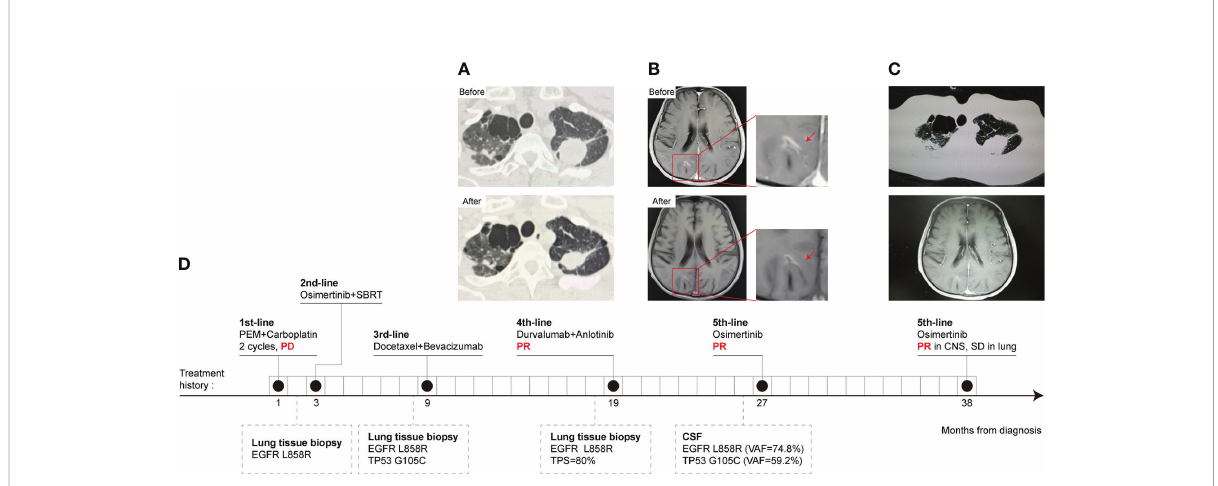
FIGURE 2 CT scans, treatment history, and gene mutation of Case 2 at different clinical time points as shown. (A) Chest CT scans. PR was observed after durvalumab plus anlotinib, fourth-line treatment. (B) MRI of the brain. A PR of LM was obtained after two cycles of osimertinib rechallenge. (C) The lung and CNS lesion kept stable till recent follow-up in April 2022. (D) The timeline of Case 2 treatment history, follow-up diagnostic and gene test results. The numbers indicate the time from the diagnosis of